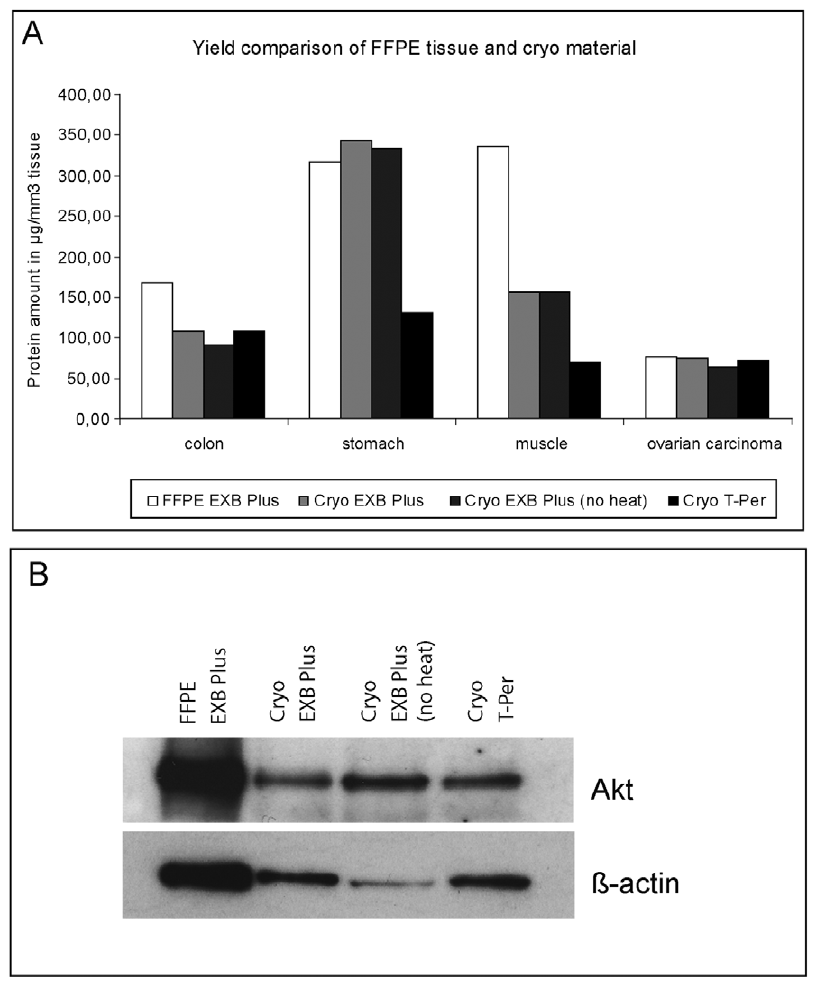
Figure 4. Comparison of proteins extracted from four FFPE tissues and the corresponding cryo tissues with EXB Plus. A Cryo tissue was additionally extracted with EXB Plus but without any heat and T-Per, a buffer designed for extraction of cryo material. To be able to compare protein yields from different sized tissue pieces the protein amount is calculated per mm 3 of used tissue. The yields extracted from cryo material with EXB Plus or T-Per were equal, or especially for stomach tissue even higher in the EXB Plus extracts. Cryo tissue compared to FFPE material discloses a loss of protein amount in two tissues (colon and muscle) and no difference in the two others (ovarian carcinoma and stomach). B Western blot analysis of protein lysates from colon FFPE and cryo material. For both tissue types we obtained clear bands in the western blot, confirming that we were able to extract non-degraded, full-length, and immunoreactive proteins. In addition it is visible that the extracted protein amount from FFPE is higher than from fresh-frozen tissue, but hardly any difference could be seen for cryo material extracted using EXB Plus compared to a standard buffer for cryo extraction (T-Per).